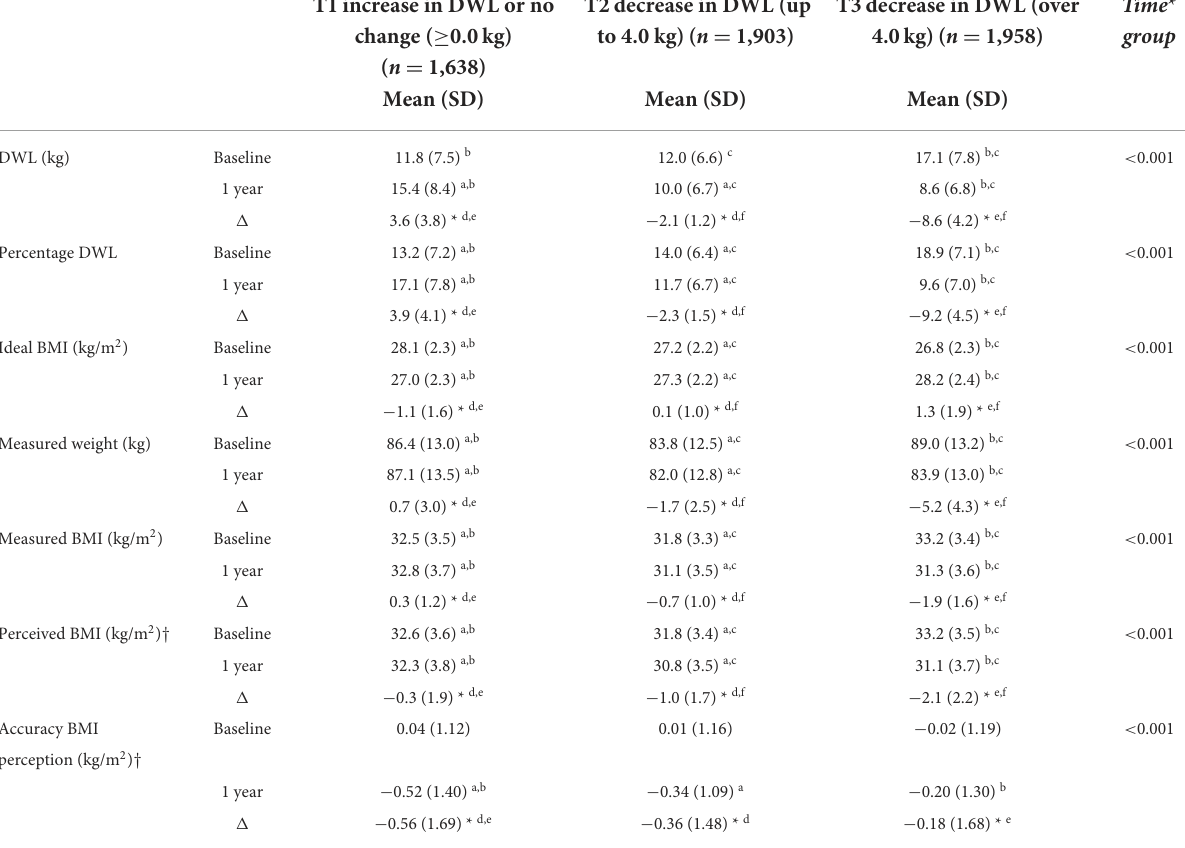
TABLE 2 Body image (real and perceived) at baseline and 1-year follow-up according to tertiles of change of